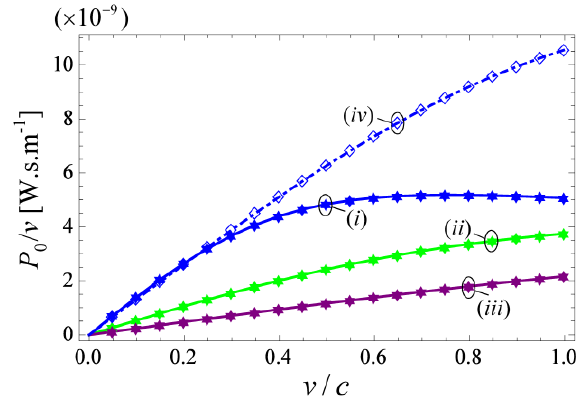
Figure 4. Stopping power ( / P v ) as a function of the normalized velocity ( / v c ) for a 0 linear array of charged particles moving inside the uniaxial wire medium (Figure 1a) formed by Ag wires, , and different values of the lattice h spacing a and radius of the wires r . ( i ) w . Solid lines: results obtained from Equation (32); Discrete symbols: numerical results based on the theory of